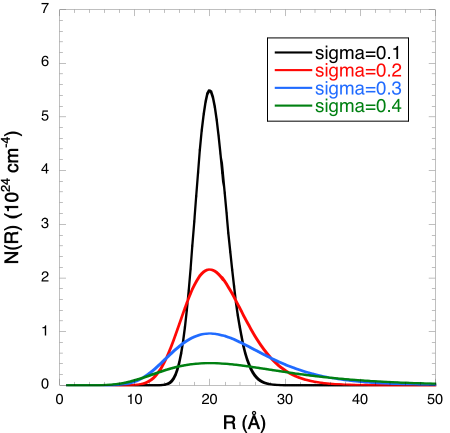
Figure 1. SDFs used to simulate the SCSs of polydisperse inhomogeneities; N o are normalized to ensure a volume fraction of 1%; R o = 20 Å; four values of σ are considered (0.1, 0.2, 0.3, and 0.4). Table 1. Nominal and calculated values of the three parameters of the lognormal SDF of spherical inhomogeneities obtained by applying the SPA to the simulated SCSs.